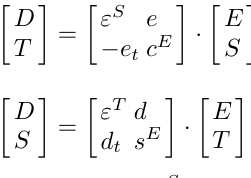
Fig. 4. Acoustic Wave propagation at 10, 60, 110, 160, 210, 260, 310, 360 micro-sec due to a lead break excitation modeled as a step input function. electrical modeling. The following derivations assume a monolithic PZT element, and ideal transfer of strain to the element. The matrix form of the piezoelectric constitutive equations can be expressed as: